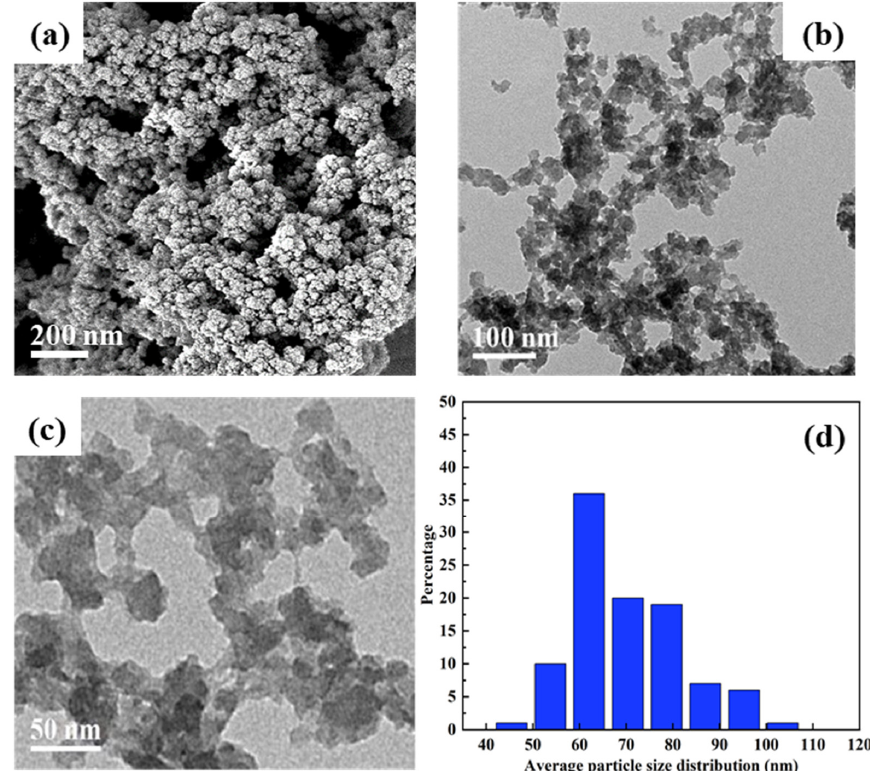
Figure 6. ( a ) SEM image, ( b , c ) TEM images; and ( d ) particle size distribution of UiO-66-DES.